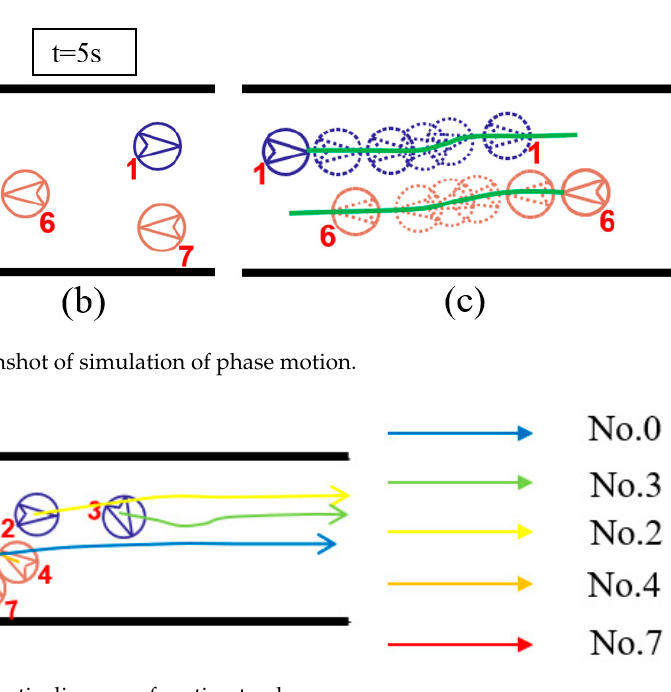
Figure 19. Schematic diagram of motion track.